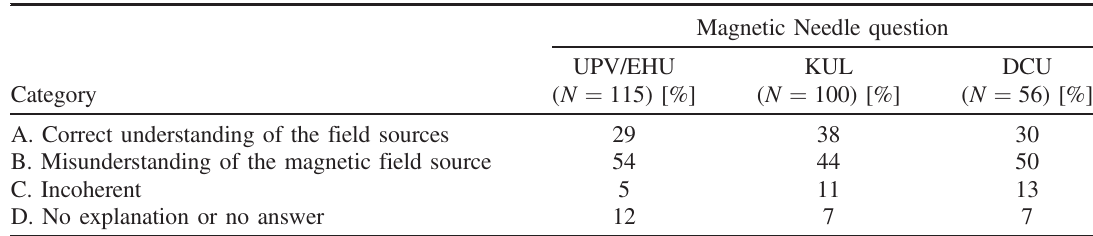
TABLE III. Categories of answers and prevalences for the Magnetic Needle